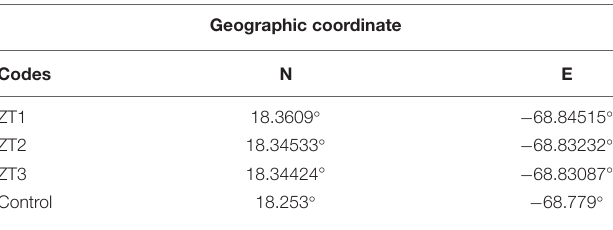
TABLE 1 | Codes and Geographical coordinate of the outplanted sites and control site in Bayahíbe, Dominican Republic. Geographic